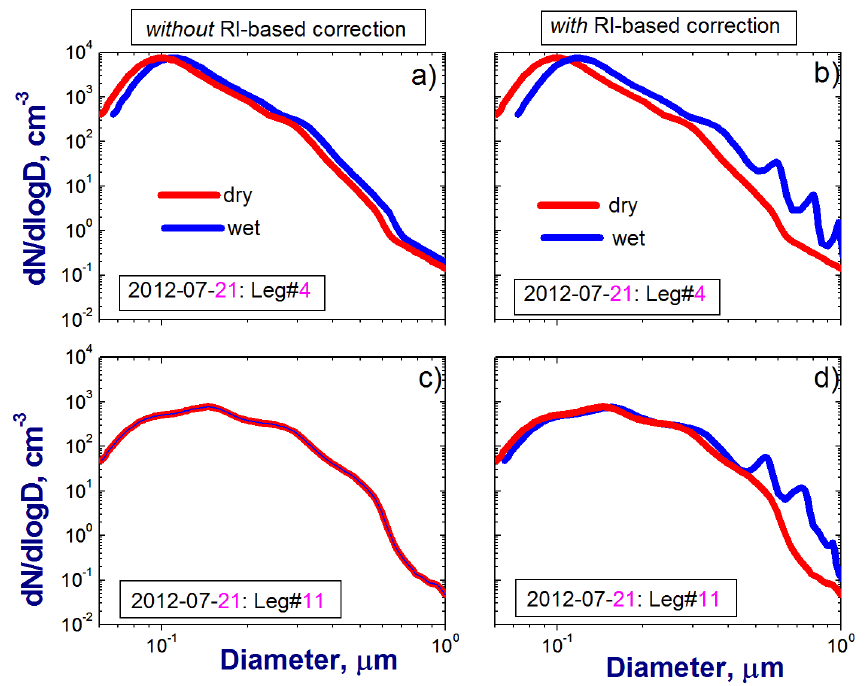
Figure 7. Example of size distributions obtained for two FLs (21 July 2012) with high ( a , b ) and low ( c , d ) values of ambient RH, respectively. Measured dry size distributions (red) are converted into their wet counterparts (blue) without (a,c) and with (b,d) the size-dependent scaling